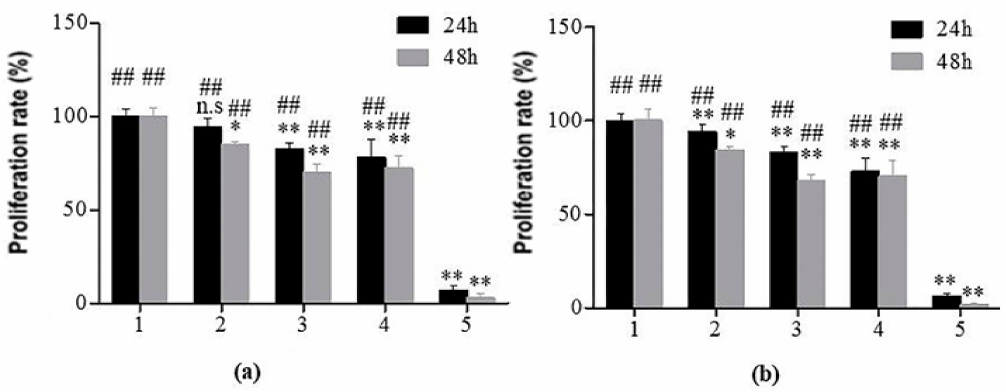
Figure 7. E ff ects of the composite hydrogel on cell proliferations. ( a ) Endothelial cells: 1, negative control, 2, SA extract, 3, TSPMAH, 4, SA, 5, positive control. * p < 0.05, ** p < 0.01 vs. negative control group; ## p < 0.01 vs. positive control group; n.s: nonsignificant, and ( b ) myocardial cells: 1, negative control, 2, SA extract, 3, TSPMAH, 4, SA, 5, positive control. * p < 0.05, ** p < 0.01 vs. negative control group; ## p < 0.01 vs. positive control group; n.s: